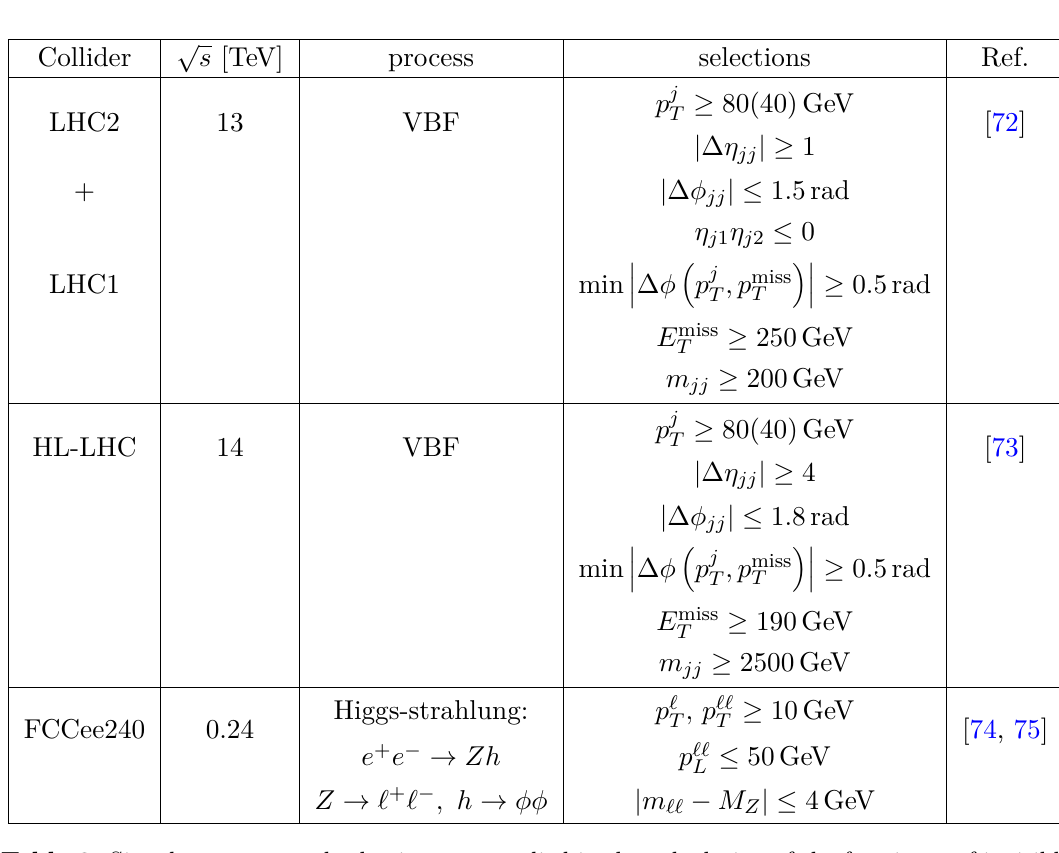
Table 3 . Signal processes and selection cuts applied in the calculation of the fraction r of invisible signal events. The p j cuts refer to the leading (subleading) jet. T naturalness according to eq. (2.22) is shown as the dotted curve. The dotted vertical